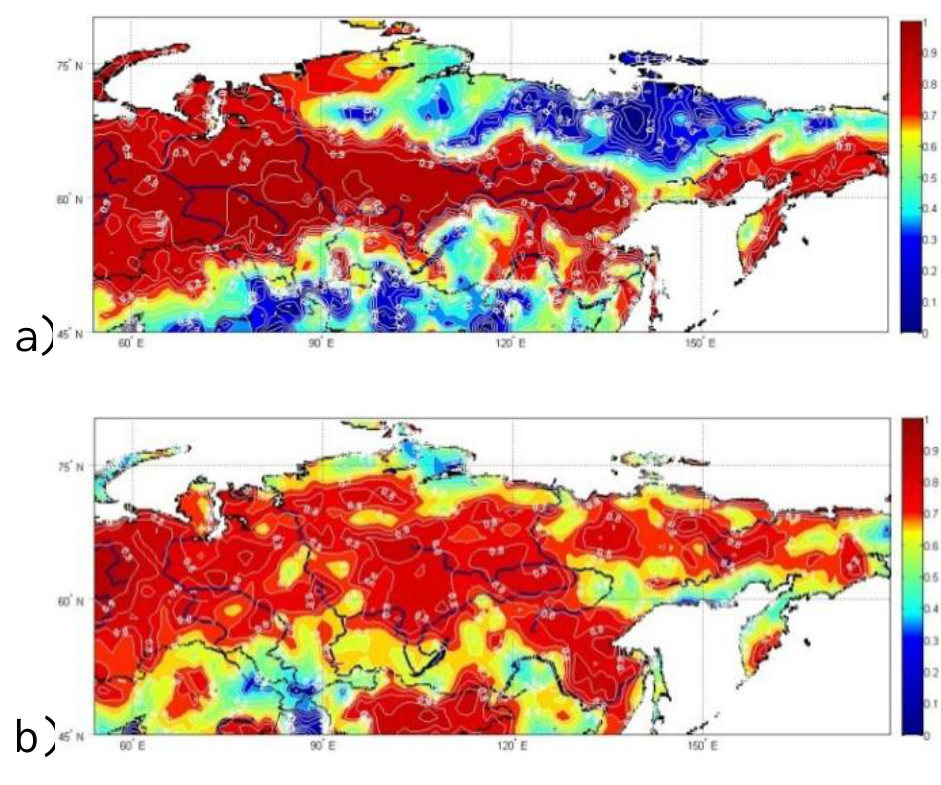
Fig. 6. The spatial distribution of determination coefficient R 2 calculated by (3) for January (a) and July (b) over ATR using JRA-25 reanalysis for the period of 1979–2008. Figure 6. The spatial distribution of determination coefficient R Table 4. Determination coefficient ( R 2 ) of regression model calcu- lated by JRA-25 reanalysis for 1979–2008. (a) and July(b) over ATR using JRA-25 reanalysis for the period of 1979-2008. 3